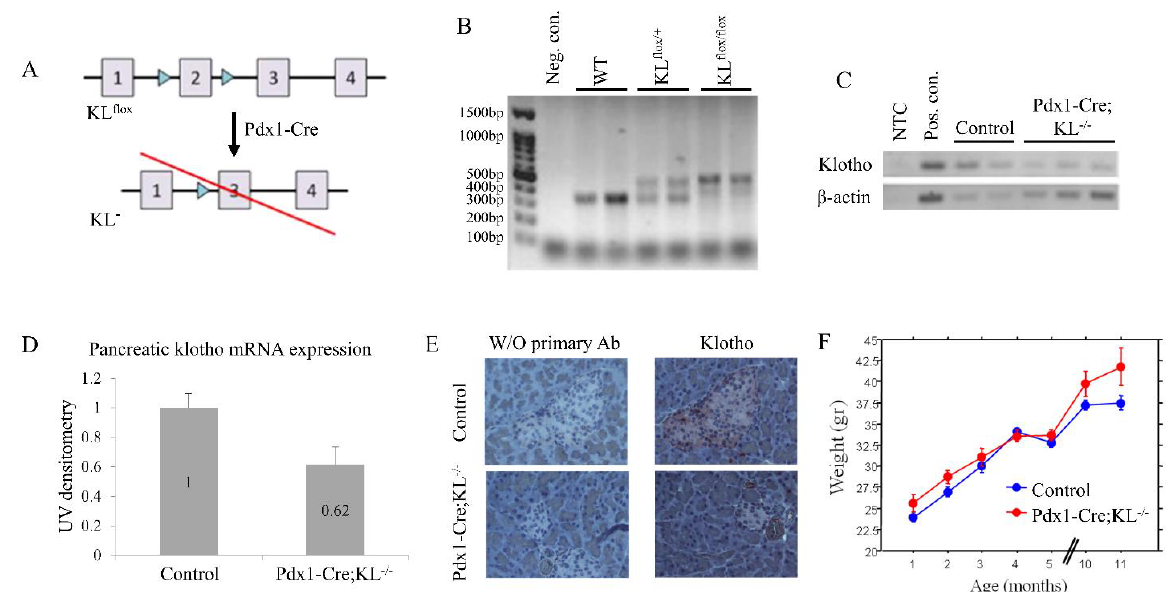
Figure 3. Generation of pancreatic KLOTHO knockdown mice. ( A ) Schematic diagram of KL flox allele: LoxP sites flank exon 2 of KLOTHO , leading to its targeted knockdown in pancreata of Pdx1-Cre; KL − / − mice. Top panel shows floxed allele, bottom panel shows expected results of Cre recombination. ( B ) Representative gel showing PCR products of mouse KLOTHO genotyping: KL +/+ (WT; 370 bp), KL flox/+ (470 and 370 bp), and KL flox/flox (470 bp). ( C , D ) Pancreatic RNA was extracted from Pdx1-Cre; KL − / − ( n = 7) and control mice ( n = 4). Klotho mRNA levels were determined by semi-quantitative RT-PCR and quantified. Representative gel shown (original uncropped blots are available as Figure S2). ( E ) Representative immunohistochemical klotho staining of pancreata excised from Pdx1-Cre; KL − / − and control mice. Magnification: X20. W/O, without. ( F ) Weight of mice in both groups ( n = 5 per group). Analyzed using repeated-measures ANOVA. p = 0.01. Data are presented as the mean ± SEM. Control, KL flox/flox mice.